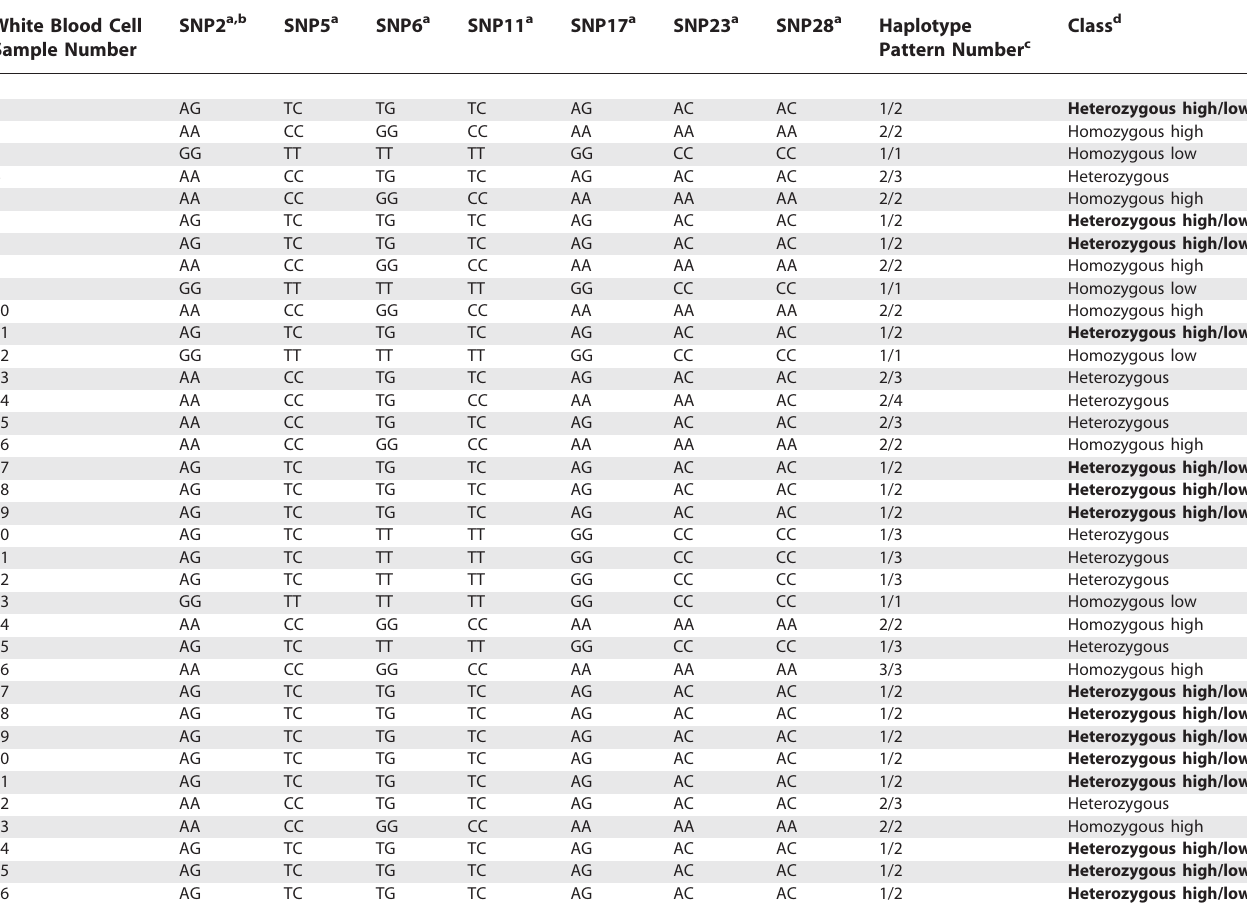
Table 2. KRT1 Interval SNP Genotypes in the 36 White Blood Cell Samples White Blood Cell Sample Number